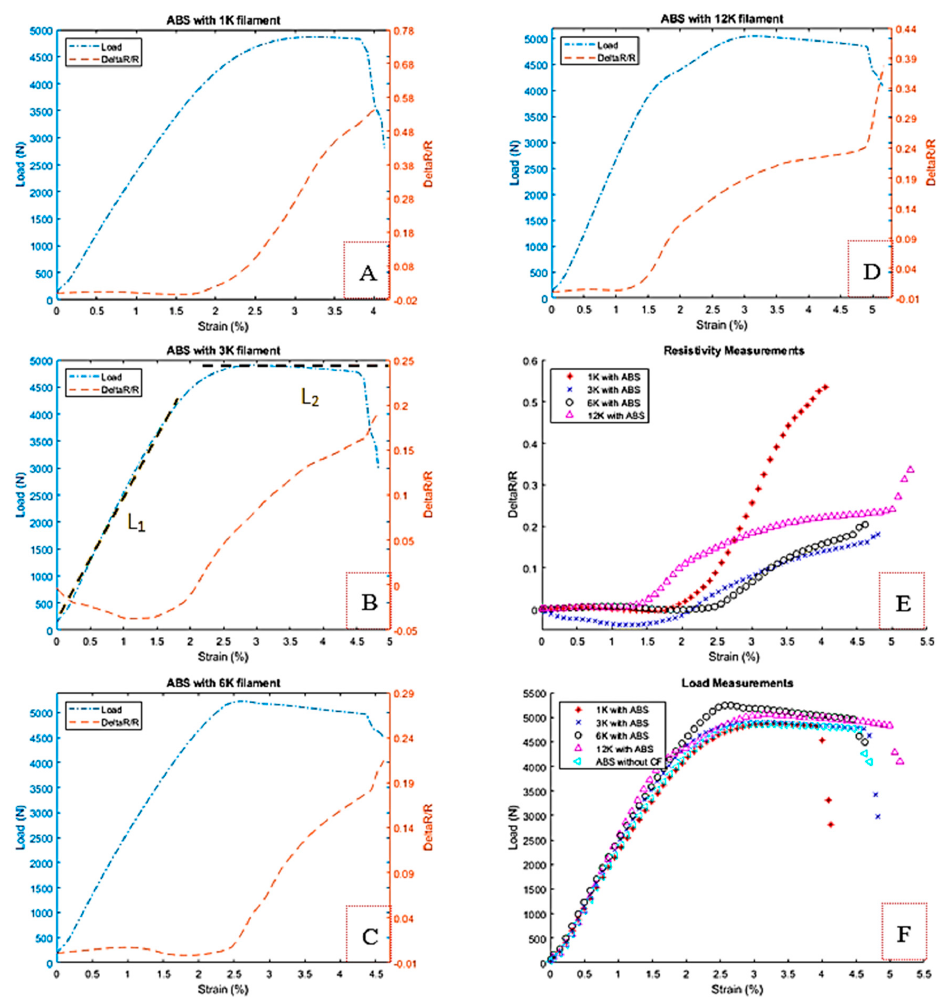
Figure 12. Resistance change and the tensile test load verses the tensile strain for ABS embedded